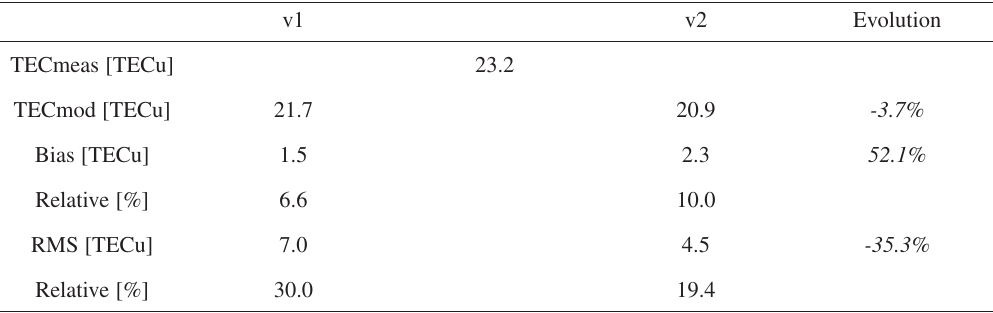
Table I. Comparison between NeQuick version 1 and 2 and GPS vertical TEC in 2002. v1 v2 Evolution TECmeas [TECu]